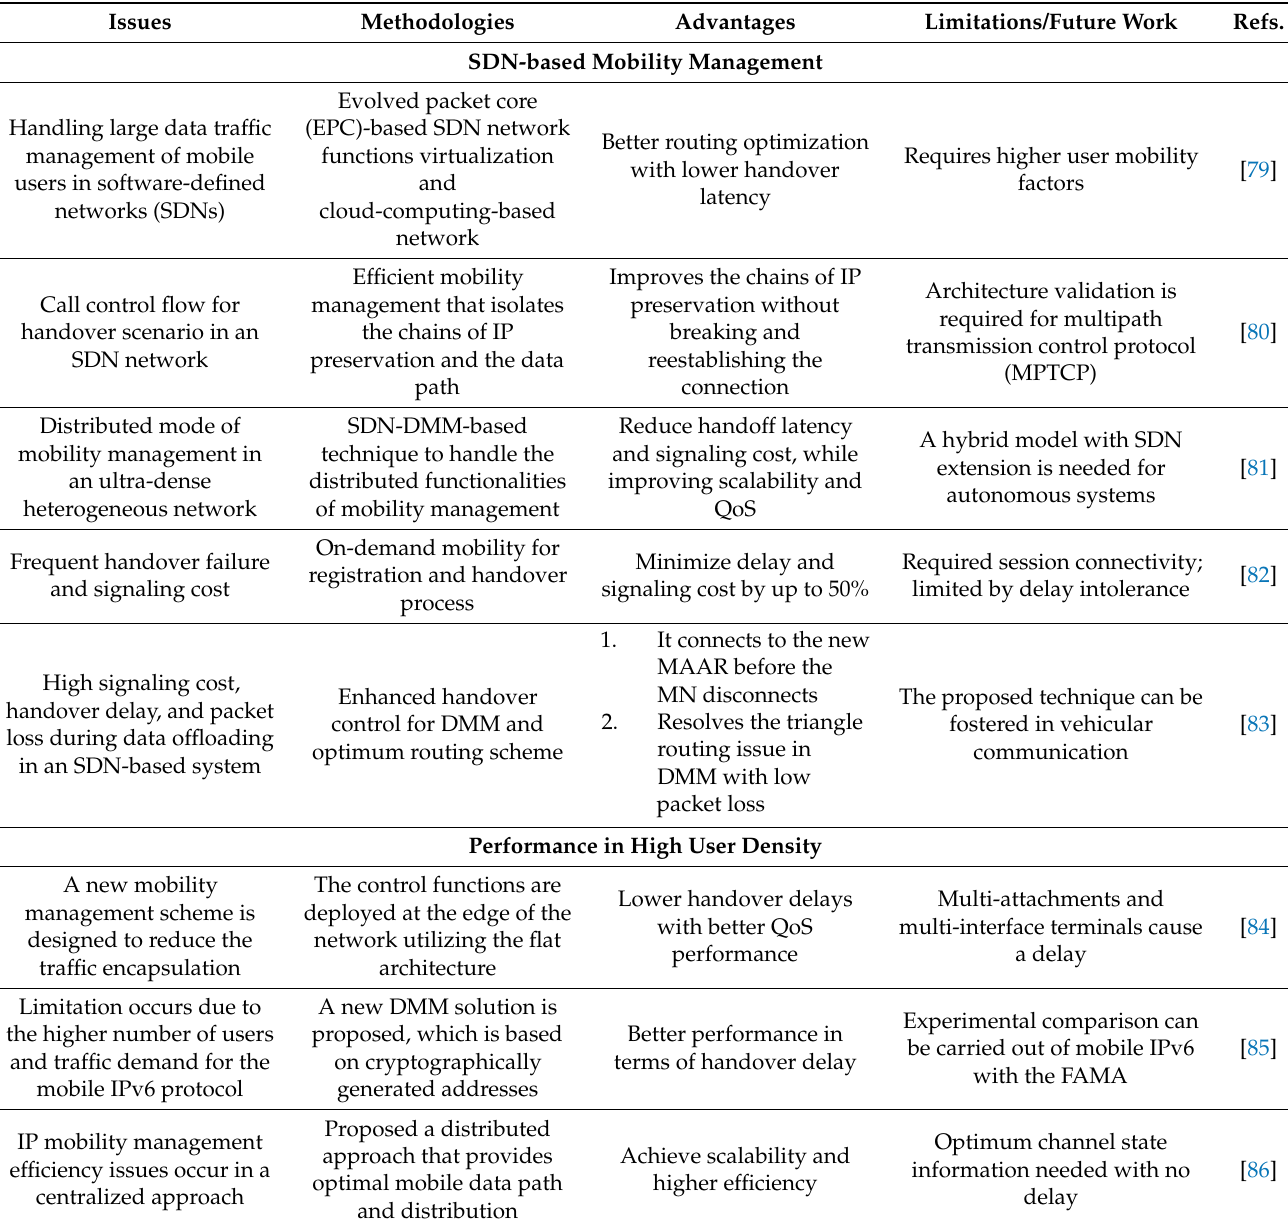
Table 2. Summary of related work for network